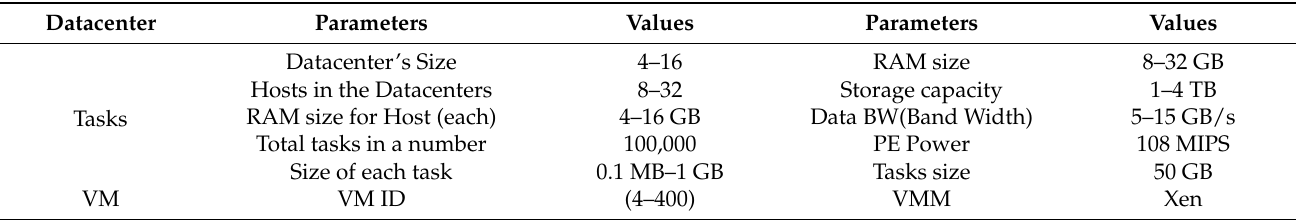
Table 2. Parameters used for AGRICLOUD in the CloudSim4.0.